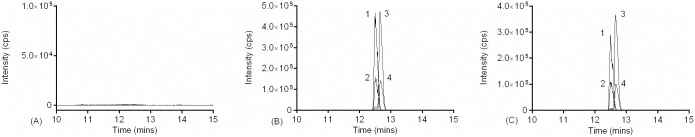
LC-MS/MS profiles of serum samples with SIM and SHA introduced in silico and in vitro.Chromatograms of (A) blank serum (B) blank serum spiked with (1) d6-SHA (156.25 ng/mL), (2) SHA (62.5 ng/mL), (3) d6-SIM (156.25 ng/mL) and (4) SIM (62.5 ng/mL) and (C) serum samples 2.5 hours after oral administration of SIM (1) d6-SHA (spiked—156.25 ng/mL) (2) SHA (3) d6-SIM (spiked—156.25 ng/mL) and (4) SIM.